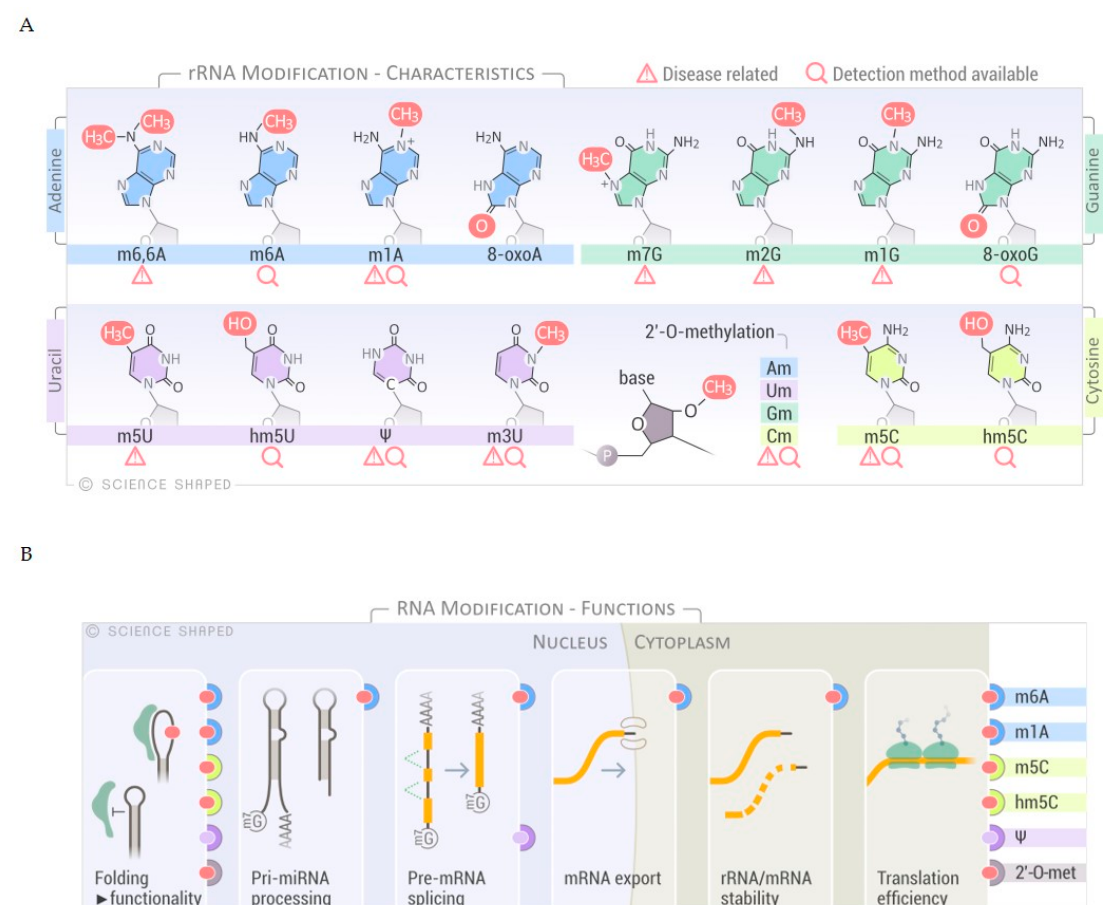
Figure 1. Overview of RNA modifications, substrates and functions. ( A ) Selected spectrum of RNA chemical modifications found in ribosomal RNA (rRNA). Disease relationships and sequencing methods are shown. ( B ) Schematic representation of the different functions of the selected RNA modifications. The modifications known to have a role in specific RNA processes are shown on the right-hand side of the panel.